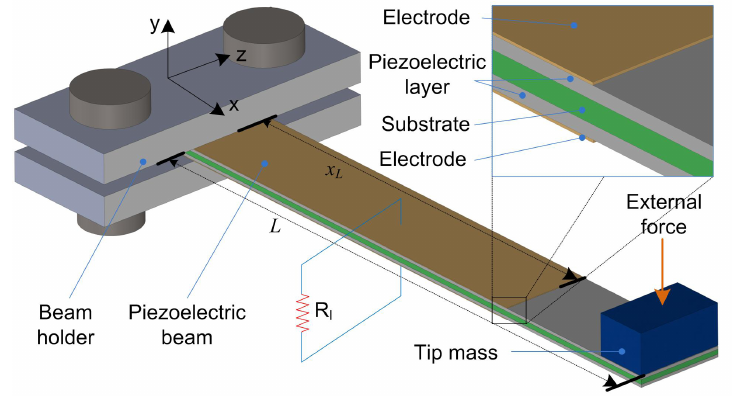
Figure 1. Schematic diagram of a general bimorph piezoelectric energy harvester with a substrate and two